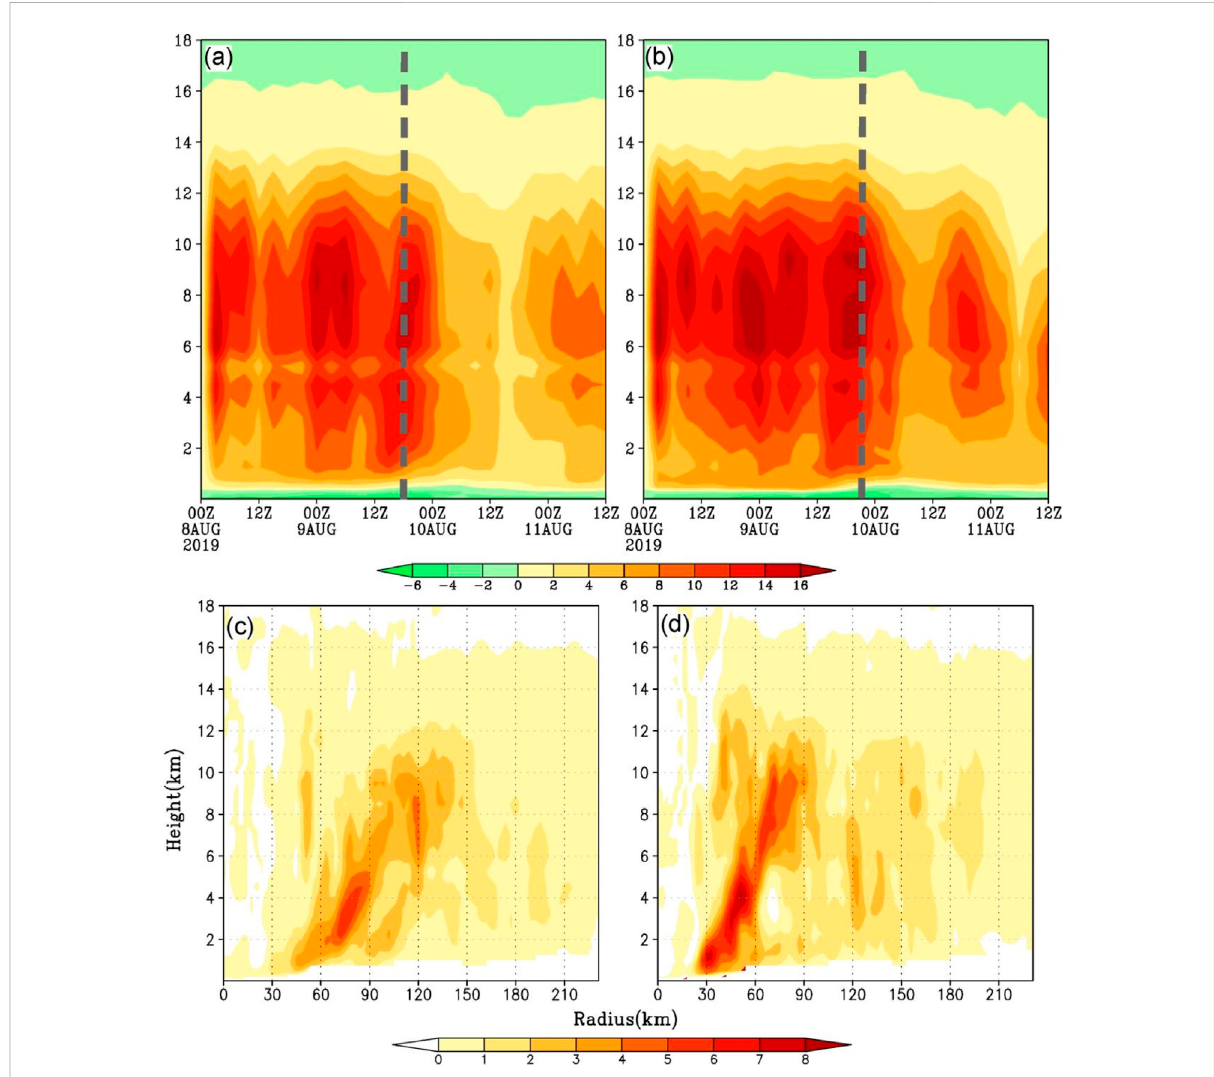
FIGURE 9 Time evolution of the vertical distribution of the azimuthal-mean diabatic heating (shaded, unit: K s − 1 ) averaged within 200 km from the typhoon center in (A) CTL and (B) PBL1. Radius – height distributionof the azimuthal-mean diabatic heating (shaded, unit: K s − 1 )at the landing time in (C) CTL and (D) PBL1. The grey dotted line indicates the landing